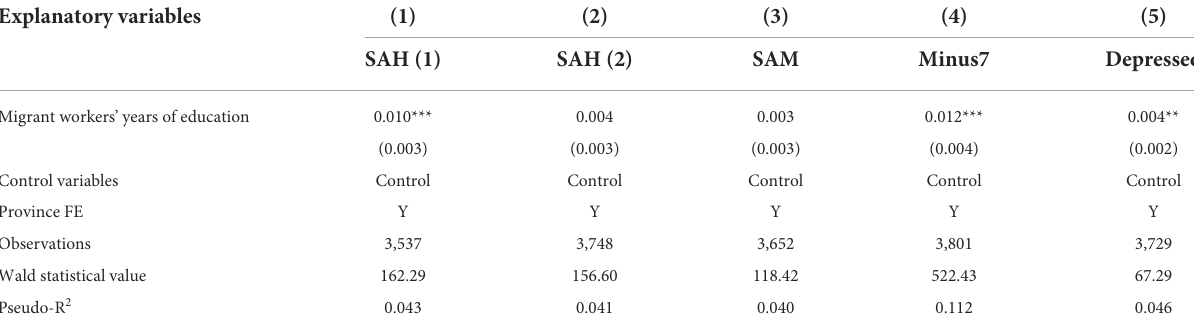
TABLE 3 Robustness test